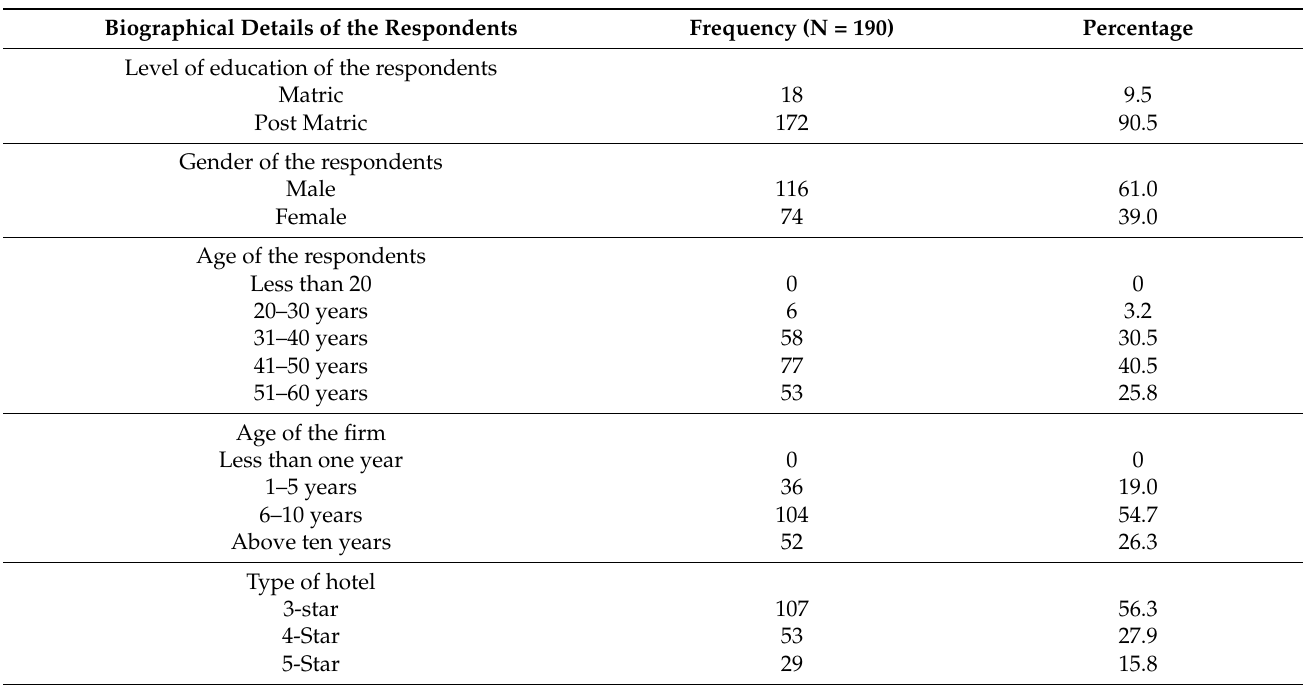
Table 1. Biographical details of the respondents.